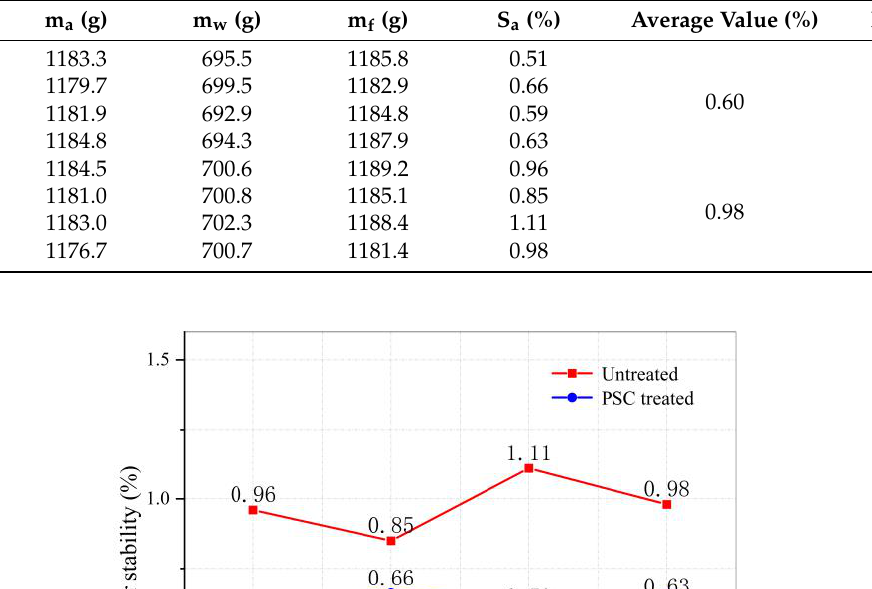
Table 3. Water absorption test results.